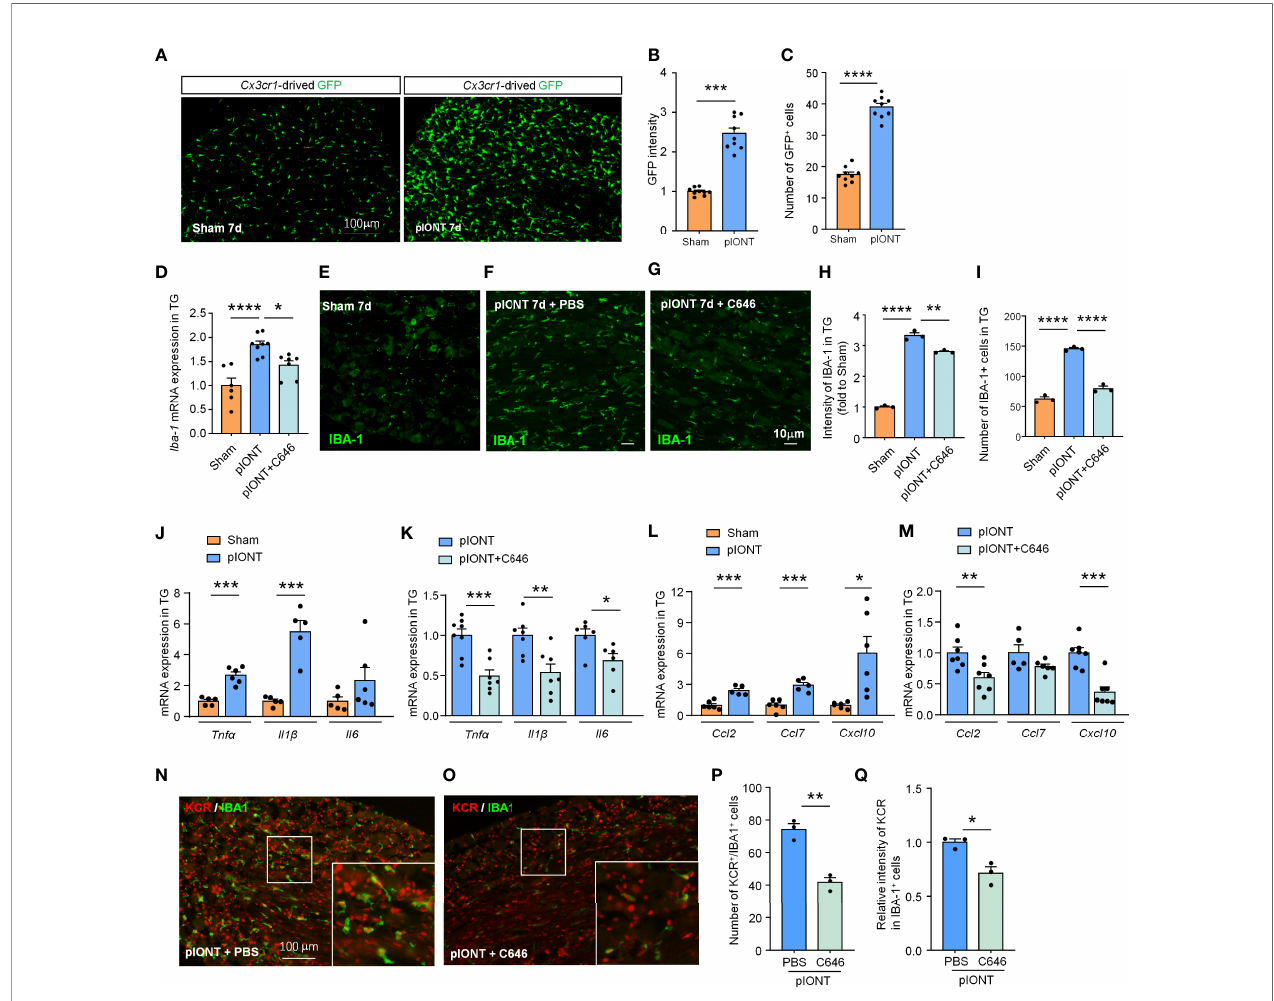
FIGURE 4 | C646 signi fi cantly inhibited pIONT-induced macrophage activation and suppressed TG ’ s upregulation of in fl ammatory cytokines and chemokines. (A – C) Cx3cr1 -GFP mice were used to visualize the activation of macrophages in TG 7 days after pIONT. The intensity of GFP expression (B) and the number of GFP-positive cells (C) was signi fi cantly increased in the pIONT group. N = 9 sections from 3 mice, each group, * P <0.05, **** P < 0.0001, one-way ANOVA followed by Bonferroni ’ s test. (D) C646 suppressed the mRNA expression of Iba-1 induced by pIONT in TG. * P <0.05, **** P <0.0001, student ’ s t-test. (E – I) Representative confocal images and immuno fl uorescence analysis data showed IBA-1 protein expression in TG. C646 (1 m g) signi fi cantly decreased pIONT-induced IBA-1 expression (H) and the number of IBA-1 positive cells (I) . N = 3 mice per group, 3 sections per mouse. ** P <0.01, **** P <0.0001, one-way ANOVA followed by Bonferroni ’ s test. (J, K) The mRNA levels of Tnf a , Il1 b and Il6 were determined using qRT-PCR. The mRNA expression of Tnf a and Il1 b were signi fi cantly increased after pIONT (J) , *** P <0.001, compared with the Sham group. However, C646 signi fi cantly decreased the mRNA expression of Tnf a and Il1 b upregulated by